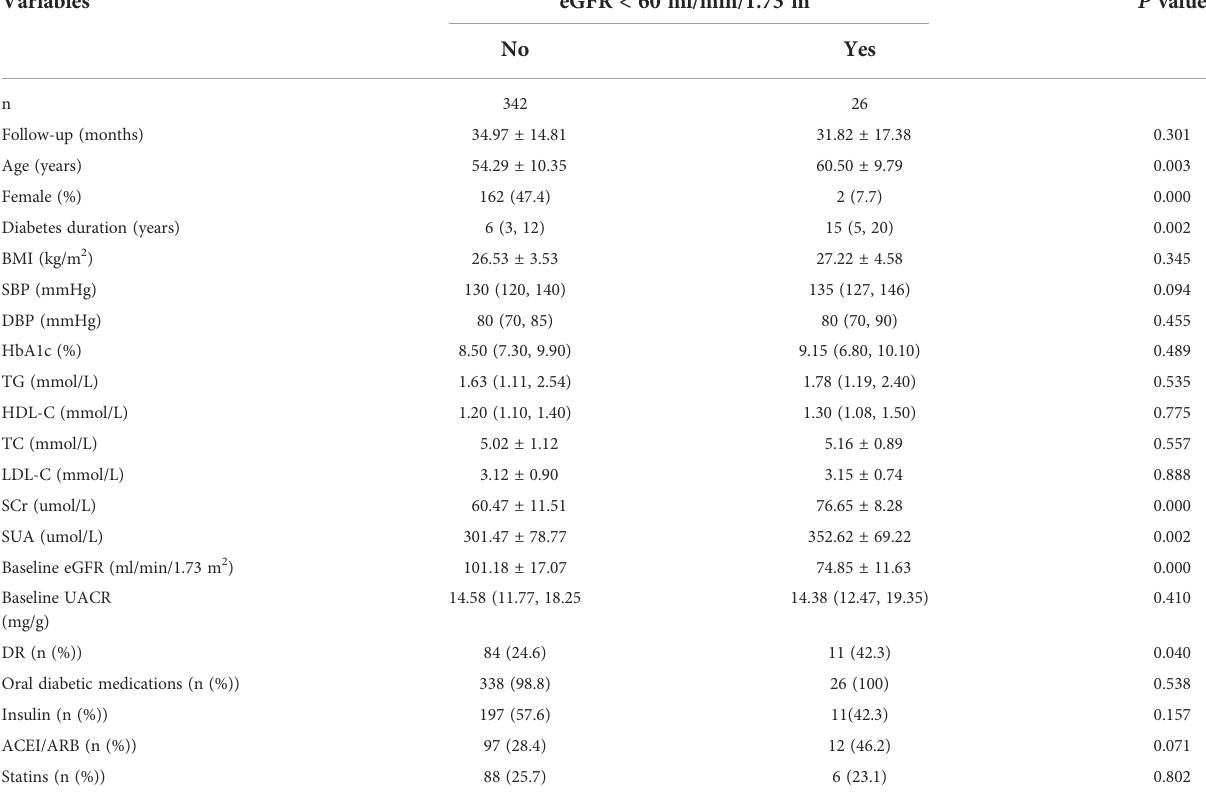
TABLE 1 Baseline characteristics of patients with T2DM according to the eGFR greater than or less than 60 ml/min/1.73 m 2 in development cohort.